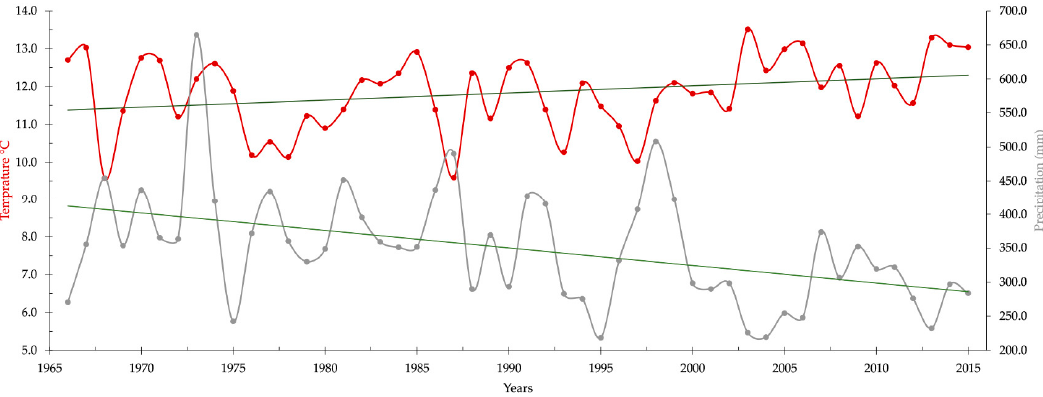
Figure 10. Time series of annual Precipitation (mm) and Temperature (°C) for the Urmia Lake basin between 1966 and 2015.